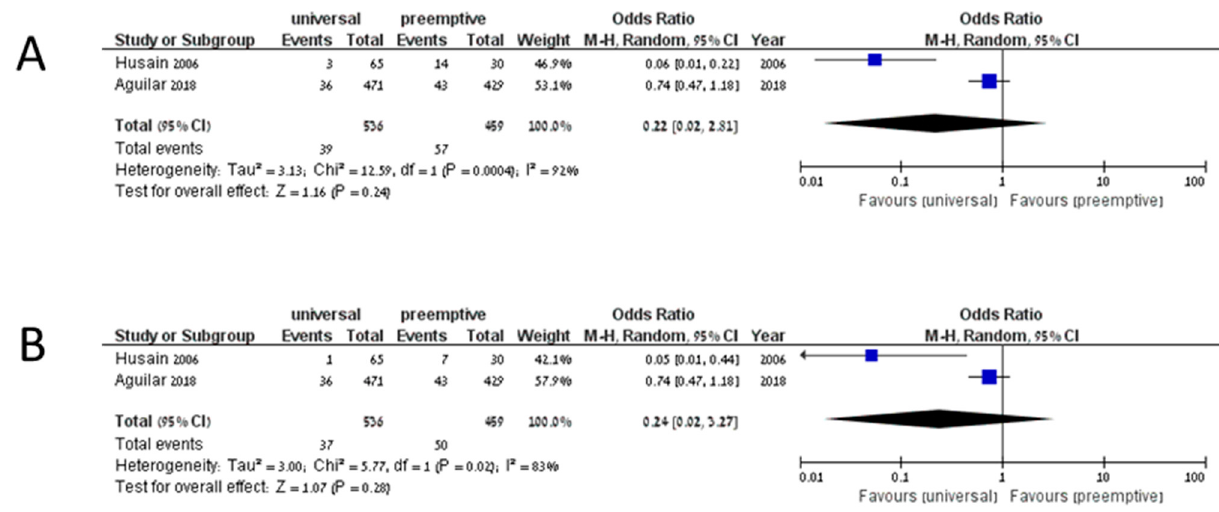
Figure 3. Invasive fungal disease ( A ) and invasive aspergillosis ( B ) in studies comparing universal prophylaxis and preemptive treatment.